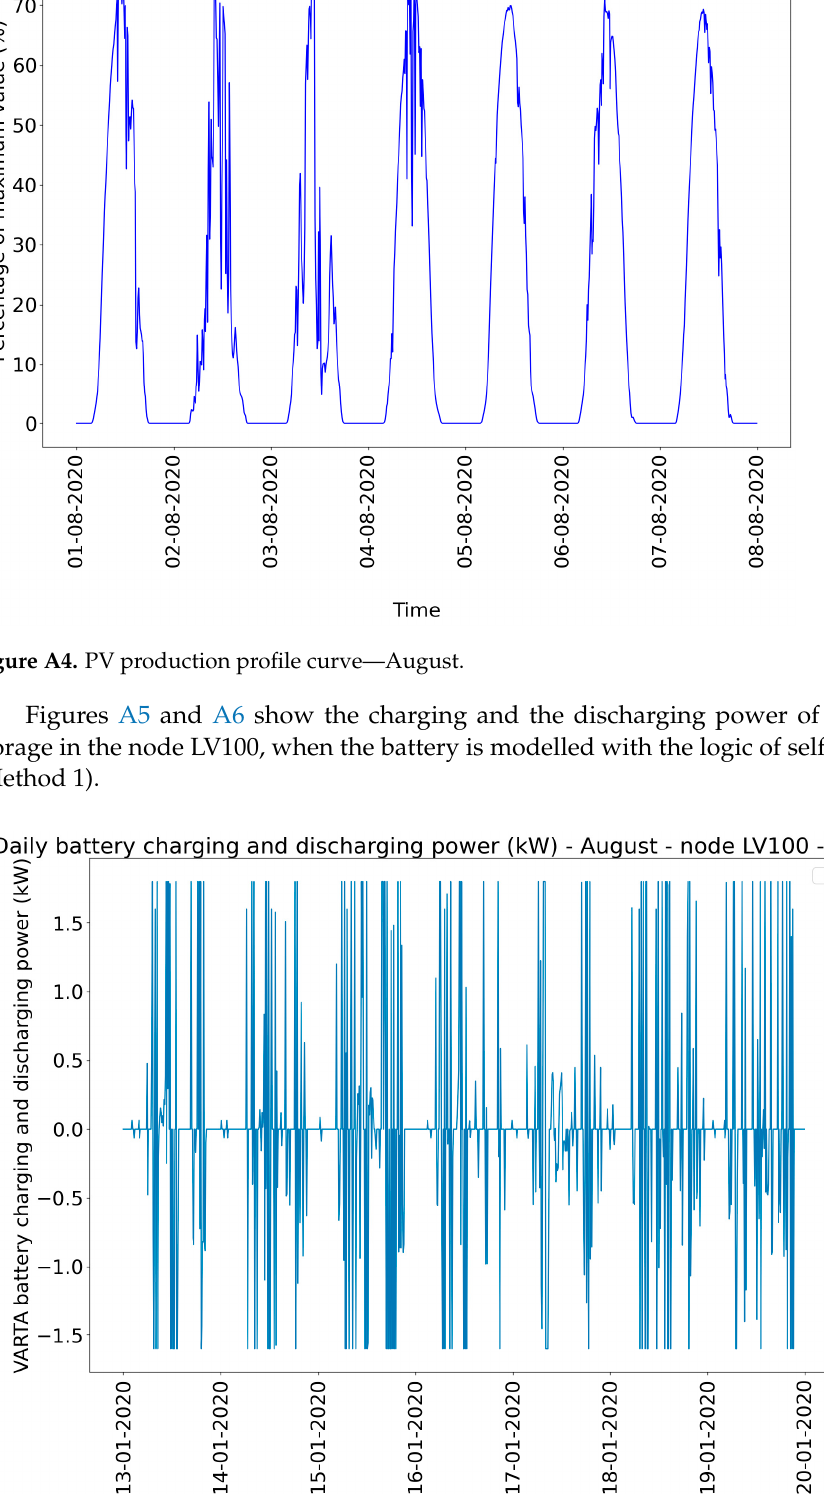
Figure A3. PV production profile curve—January.